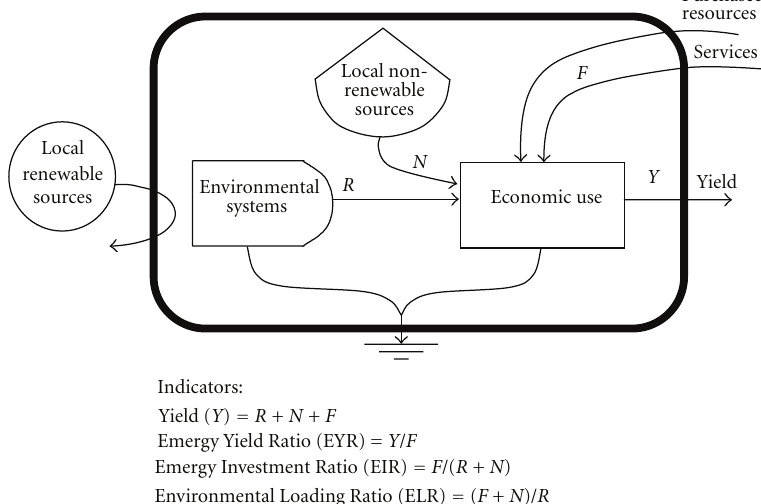
Figure 2: Systems diagram showing aggregated resource flows for environmental production. Emergy flows along thick lines; thin lines to the heat sink represent the loss of available energy/exergy that occurs with all transformations. R : renewable; N : nonrenewable; F : purchased.